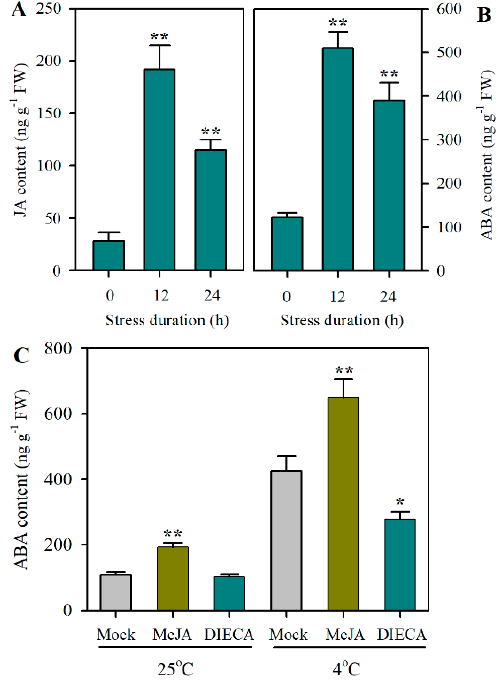
Figure 1. Accumulations of JA and ABA in tomato leaves under cold stress. ( A ) JA levels; ( B ) ABA levels; ( C ) changes in ABA levels as affected by exogenous MeJA and DIECA. Tomato plants at the 4-leaf stage were subjected to cold stress at 4 °C for 24 h. Leaf samples collected at 12 h and 24 h following cold stress were used for determination of accumulations of endogenous JA and ABA. Exogenous MeJA and DIECA were applied 12 h prior to cold treatment and ABA levels were determined following 24 h of cold stress. Data presented are means of three biological replicates ( ± SD). Asterisks indicate significant differences (** p < 0.01, * p < 0.05) according to Student’s t -test. FW, fresh weight; MeJA, methyl jasmonate; DIECA, sodium diethyldithiocarbamate.